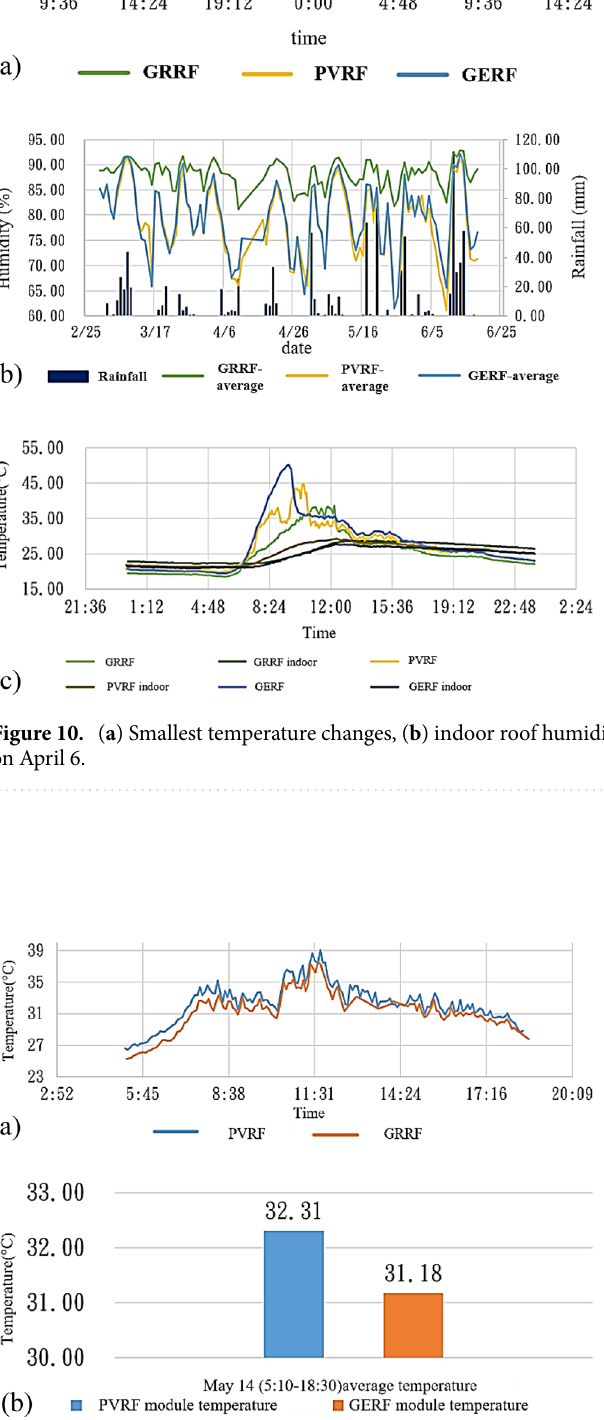
Figure 11. ( a ) Temperatures and ( b ) mean temperatures of the solar panels on May